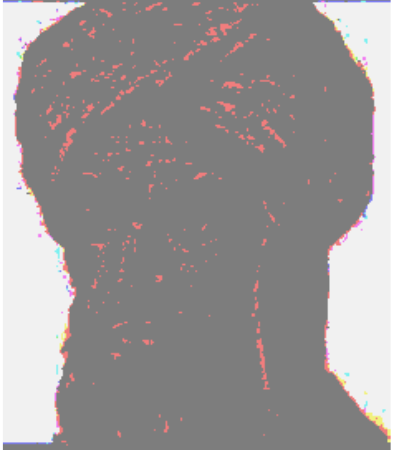
Figure 32. Archimedes using FP-Conv-CM .